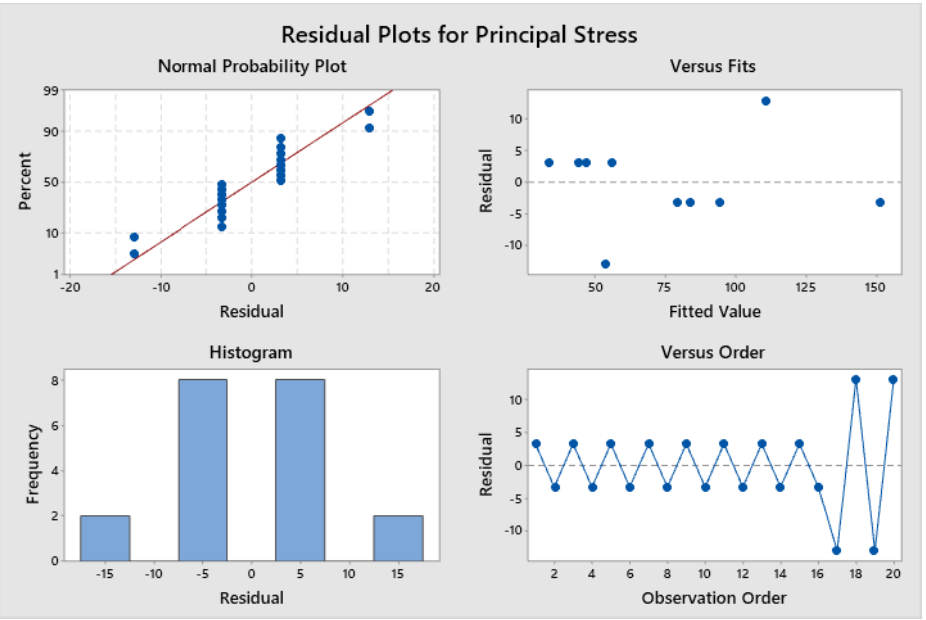
Figure 11. The residual plot of principal stress (six locking screws).